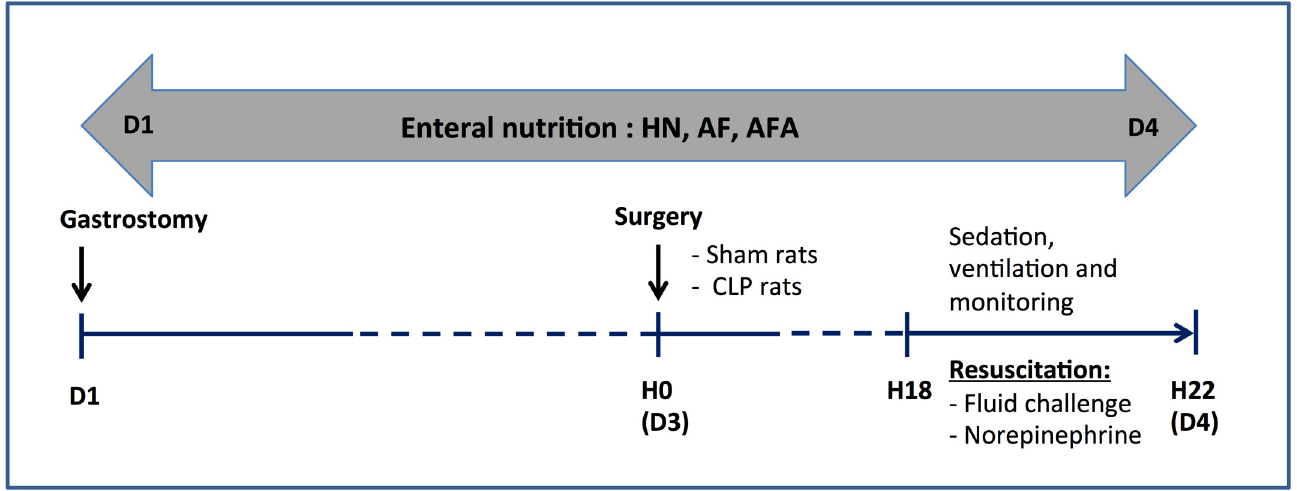
Fig 1. Protocol design. Gastrostomy was performed on day 1 (D1). Rats were then fed with different enteral nutrition products (Peptamen 1 HN –“ HN ” , Peptamen 1 AF –“ AF ” , Peptamen 1 AF enriched with arginine –“ AFA ” ) for three days (72 hours) before undergoing peritonitis by cecal ligation and puncture (CLP) or SHAM operation on day 4. Septic shock developed within 18 hours after surgery in the CLP group. Therefore from H18 to H22 after SHAM/CLP surgery, rats were resuscitated using fluid challenge and norepinephrine to target a mean arterial pressure (MAP) value over 100 mmHg. Blood, organs and vessels were collected at the end of the